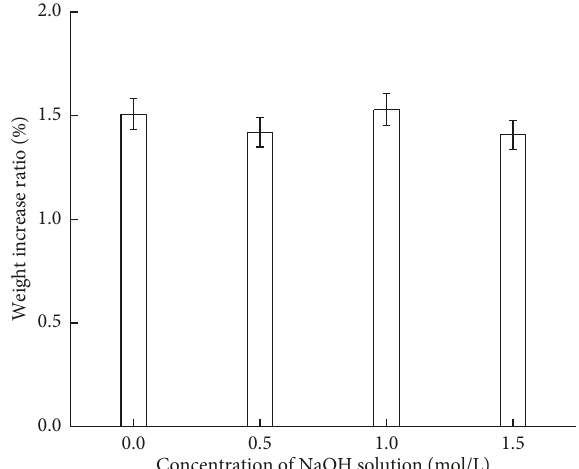
Figure 1: Loading content by alkali erosion at different concen- trations of NaOH solution.